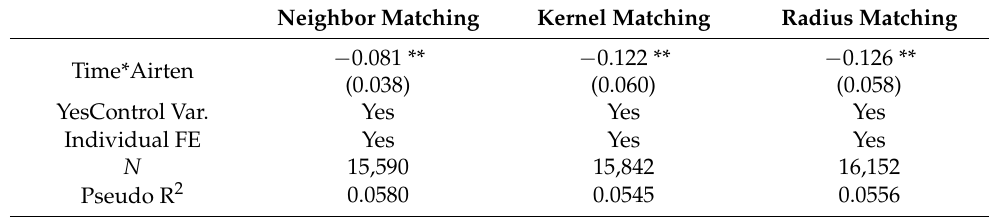
Table 8. Ordinal logistic regression results of different PSM matching methods. Neighbor Matching Kernel Matching Radius Matching Time*Airten YesControl Var. Individual FE Yes